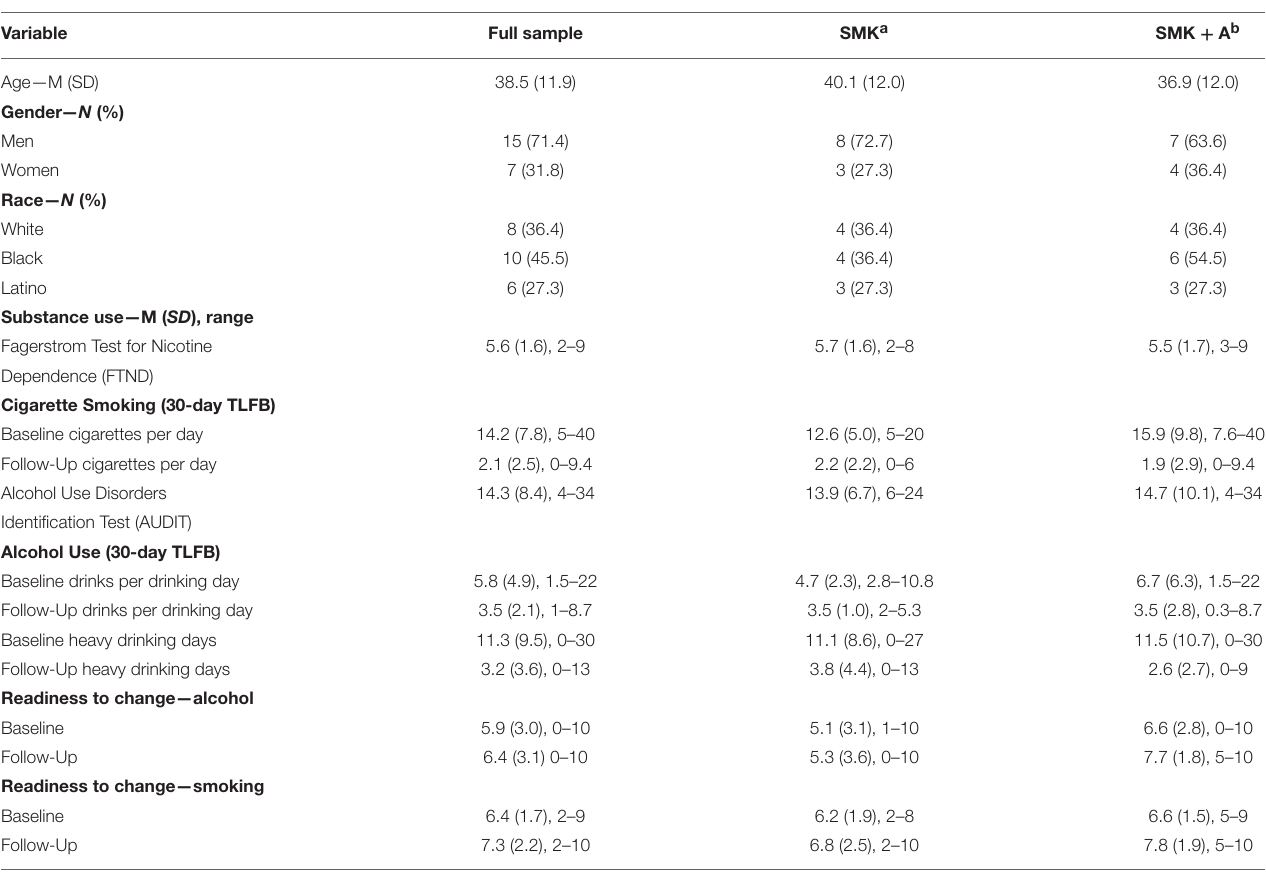
TABLE 1 | Sample characteristics ( N =